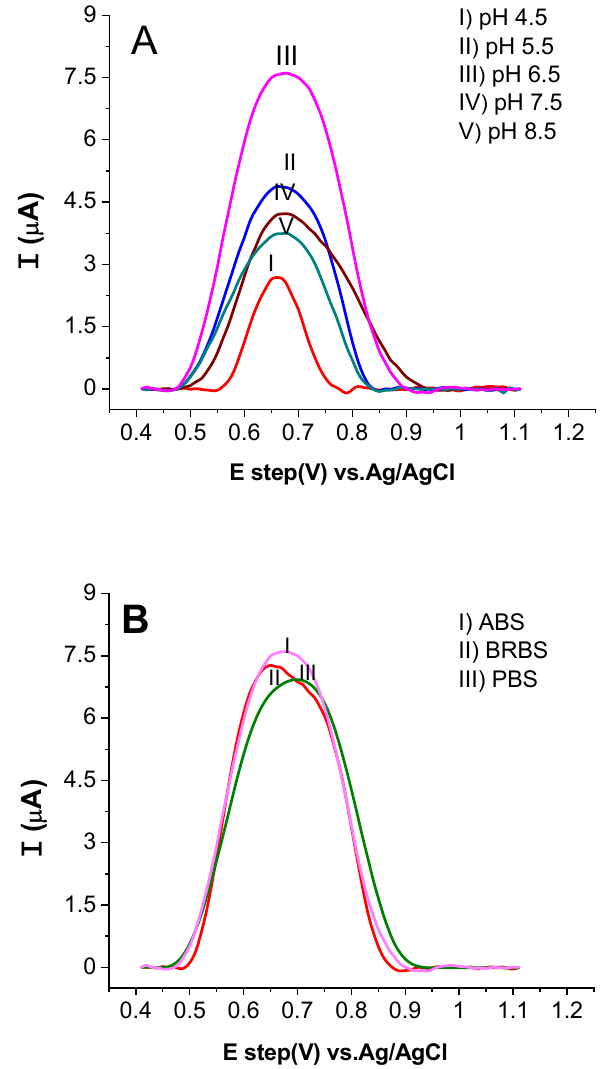
Figure 6. SWV measurement of 250 μM CR ( A ) in 0.1 M ABS at different pH values and ( B ) in different buffer solutions at pH 6.5.